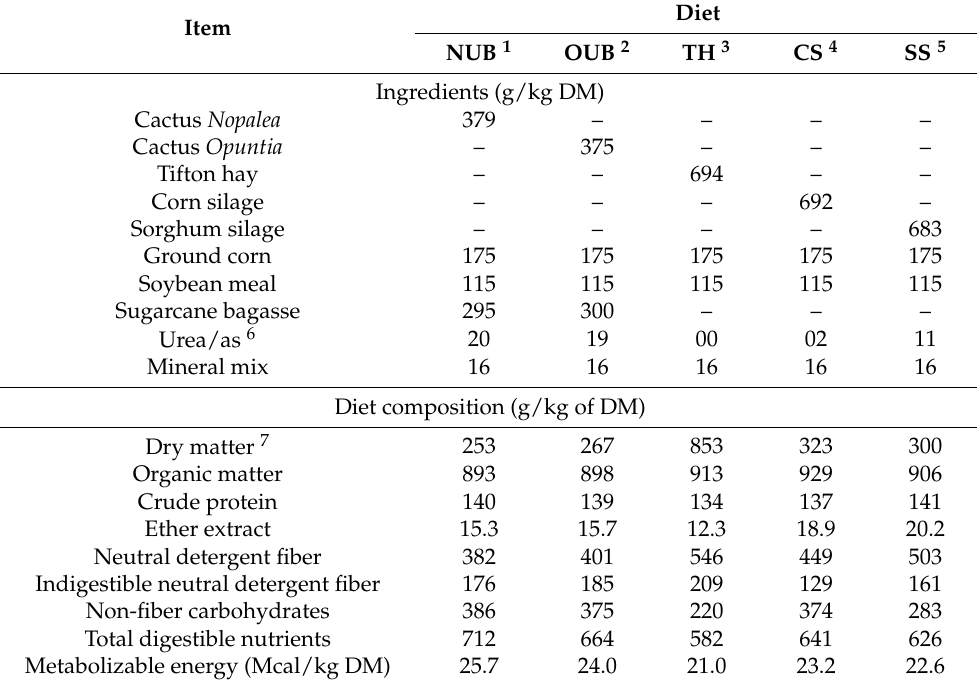
Table 2. Proportion of ingredients and chemical composition of the experimental